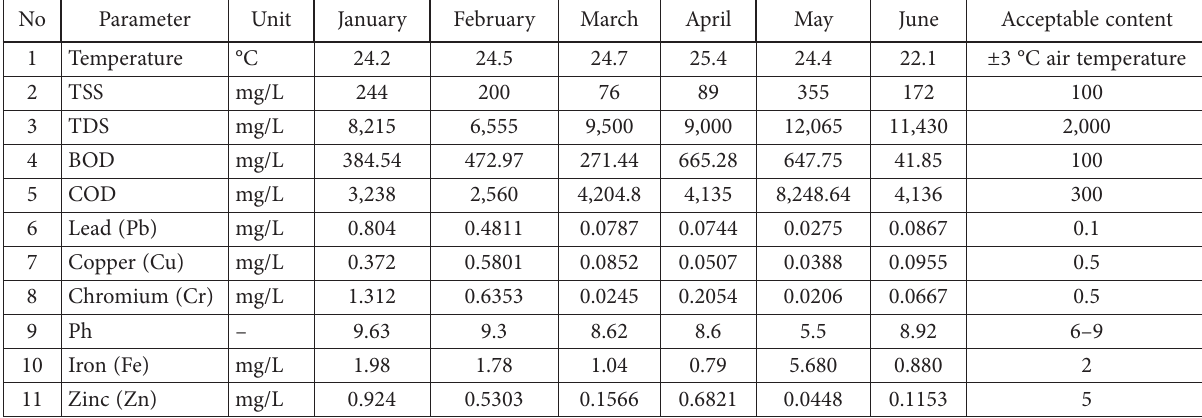
Table 5. Properties of leachate sample from January to June 2021 (source: Balai Pengelolaan Sampah, 2021) No